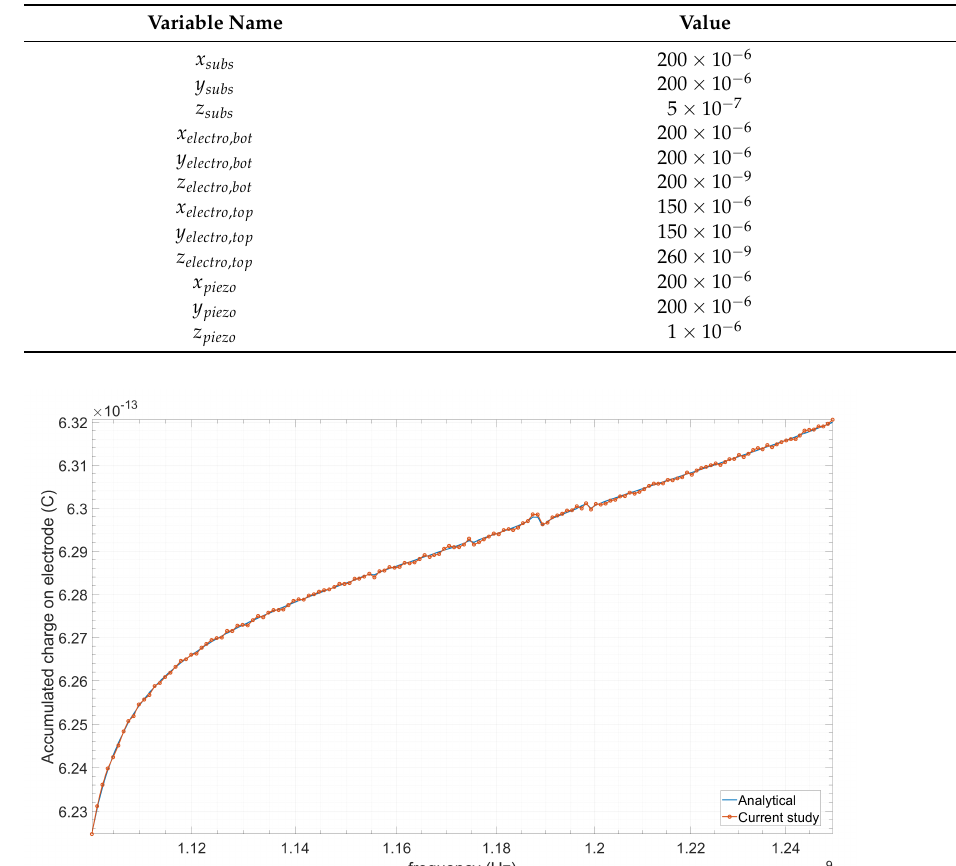
Figure 7. Accumulated charge on electrode as a function of frequency estimated by FEM and ANSYS.